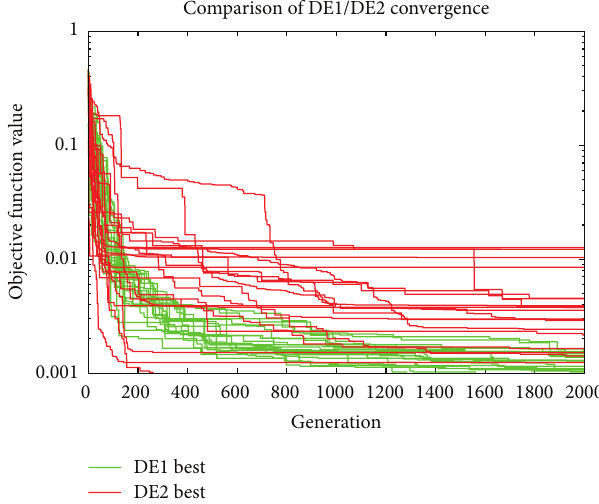
Figure 7: Comparison of convergence rate between DE1 and DE2 with multiobjective cost function. Twenty runs per DE variant. Population size